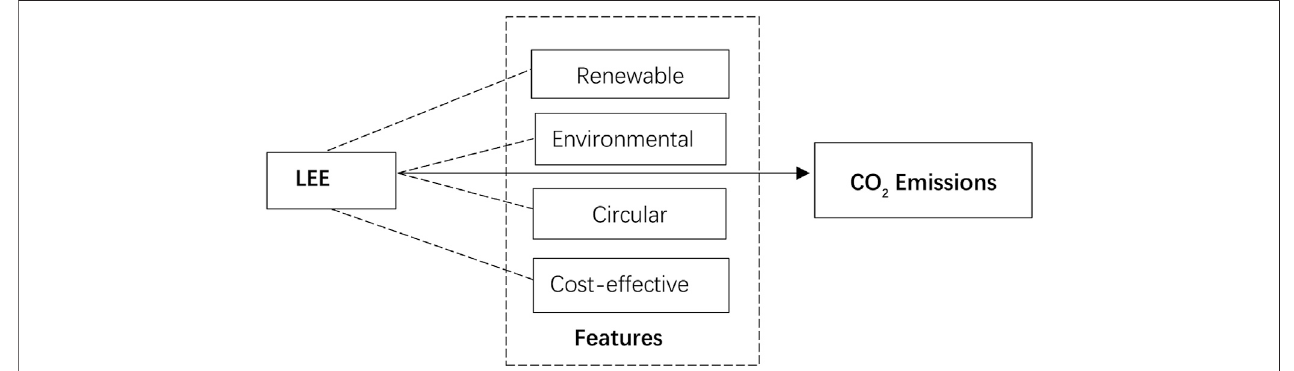
FIGURE 1 | Features of LEE and its in fl uences on CO 2 emissions.